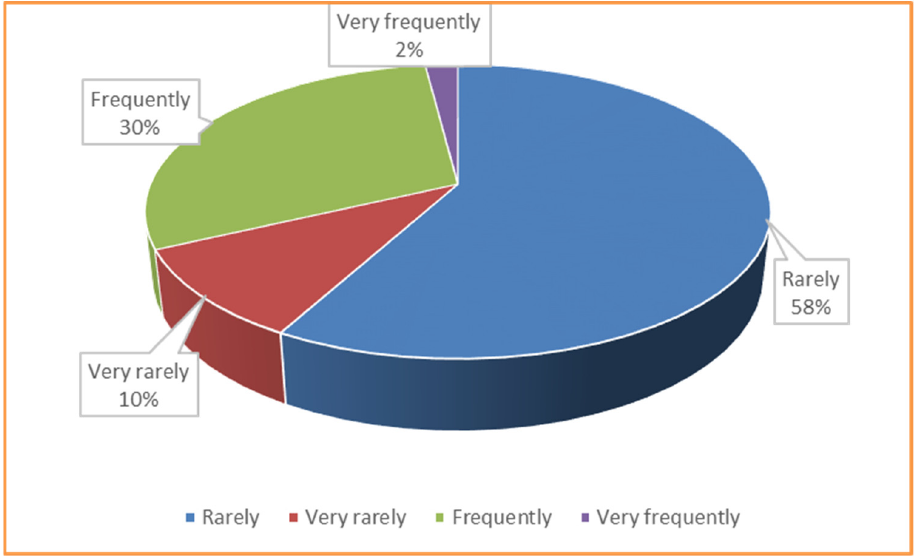
Figure 3. Severity of land degradation as perceived by the